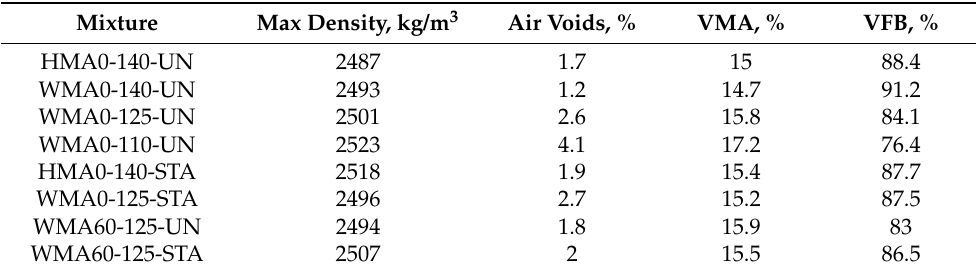
Table 2. Volumetric analysis